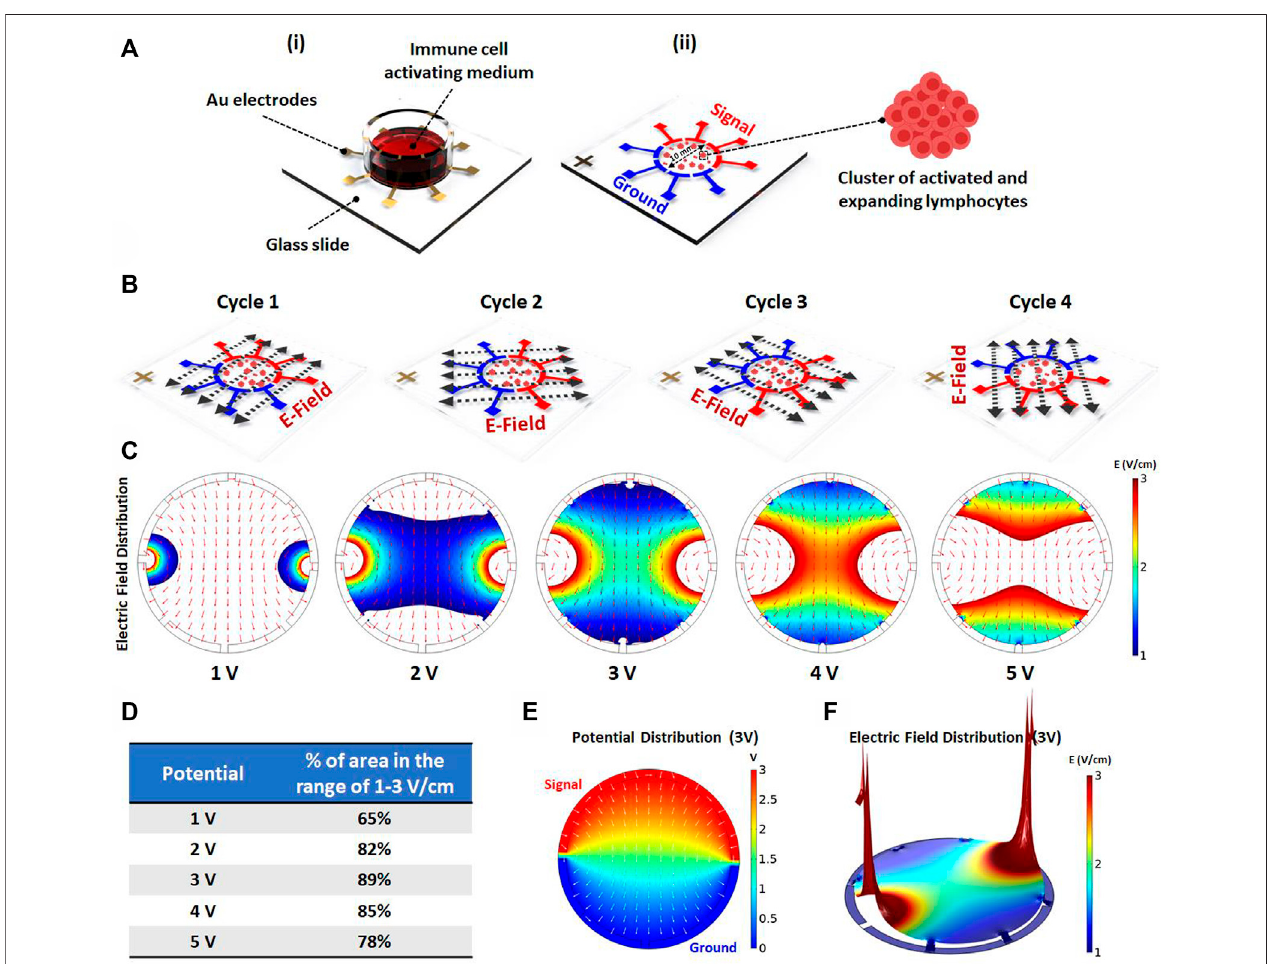
FIGURE 1 | (A i ) Schematics showing the electric fi eld stimulation set-up. The set-up structure consists of Au patterned electrodes on a glass slide to generate alternating electric fi elds in four directions. The PBMCs are cultured inside the immune cell activation medium, which is placed on Au patterned electrodes. (A ii ) The 100 kHz alternating voltage is applied to two groups of electrodes (each group containing four electrodes) in order to obtain uniform electric fi eld distribution inside the immune-cell activation medium containing clusters of activated and expanding lymphocytes. (B) The electric fi eld stimulation system was designed to periodically change the electric fi eld direction in four cycles (each cycle lasts for one second) to increase the chance of parallelism between the electric fi eld direction and the axis of cell division. (C) The electric fi eld distribution inside the immune cell activation medium was studied using COMSOL Multiphysics AC/DC module. The simulation was performed for different applied voltages to evaluate the area percentage stimulated with preferred electric fi eld intensity (1 – 3 V/cm) for each voltage. (D) The area percentagestimulated withpreferredelectric fi eldintensitywasquanti fi edforeach voltage. Thesimulation demonstratesthatthehighestareapercentage isobtainedby 3(Volts)stimulationvoltageamplitude. (E) Thesurfaceplotshowstheelectricpotentialdistributioncorrespondingtotheoptimumappliedvoltage.Thenormalizedarrow surface plot demonstrates the electric fi eld directionaldistribution. (F) The colorrange-limited 3D plot illustrates the electric fi eld intensity distribution inside the